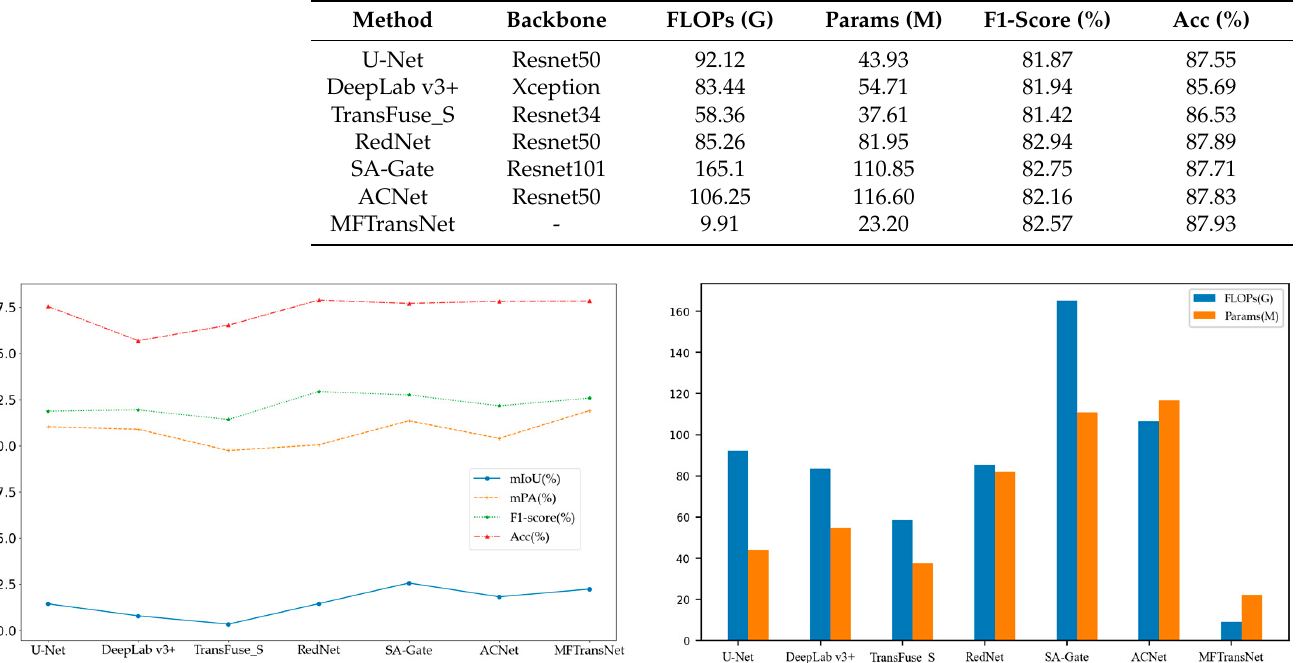
Figure 9. Visualization results of MFTransNet and SOTA methods (white: impervious surfaces; cyan: low vegetation; blue: buildings; yellow: cars; green: trees; and red: clutter/background). Table 4. Comparison of model size and accuracy.